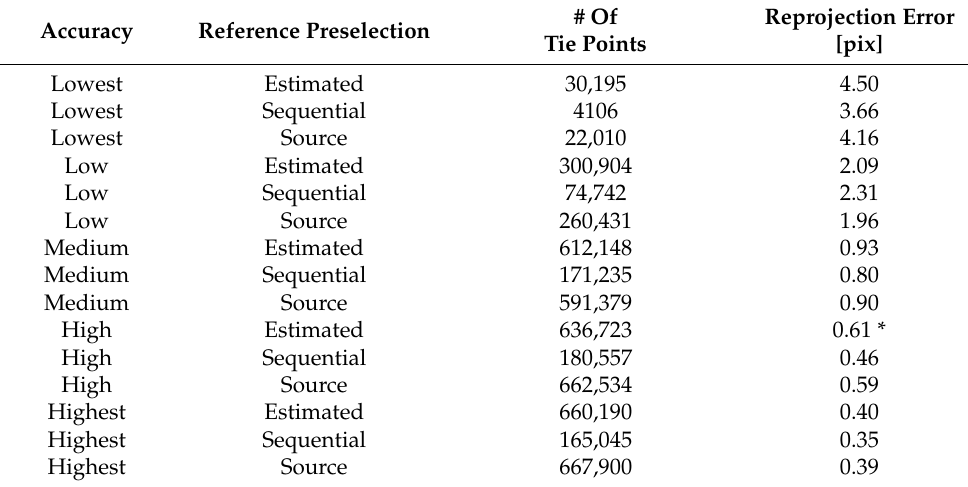
Table 1. DJI Phantom 4 PRO photos alignment results.